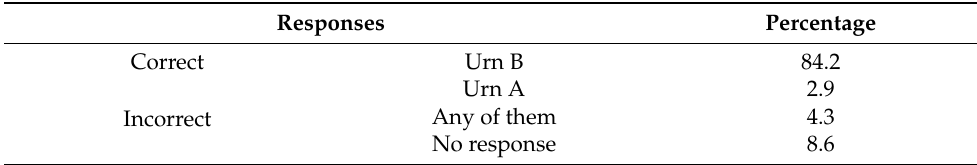
Table 4. Responses given to Task